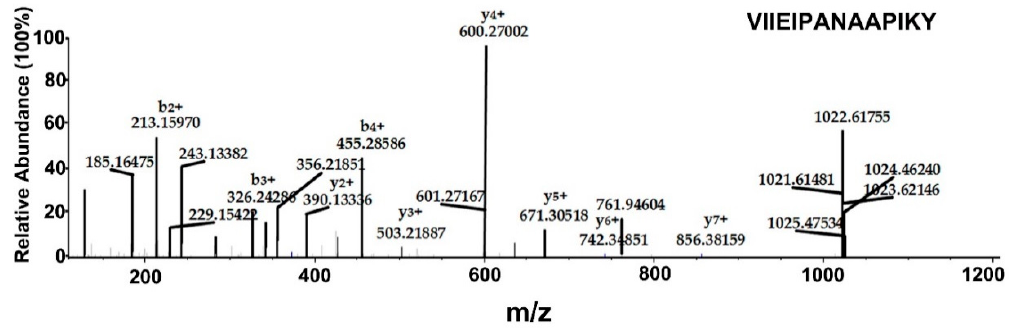
10 of 18 Figure 8. Gel filtration analysis of the global fold of AbPPase. ( A ) Gel filtration profile of AbPPase in the presence of 1.6 mM PPi and 1.6 mM MgCl 2 . The elution peak of AbPPase falls at 13.36 mL. ( B ) The gel filtration profile of AbPPase in the presence of 200 mM NaCl,1.6 mM PPi and 1.6 mM MgCl 2 . The elution peak of AbPPase falls at 13.32 mL. 2.4. AbPPase Lys30 is Phosphorylated during PPi Hydrolysis Here, we used MS to identified chemical modifications of AbPPase during PPi hydrolysis. After 10 min of the enzyme reaction, chymotrypsin was added to the reaction to digest AbPPase, and unreacted AbPPase was used as a negative control. MS identified 45 peptides, covering 98.2% of the enzyme. Our results showed that several methionine and cysteine residues could be oxidized and carbamidomethylated, respectively (Table 2). During hydrolysis, Lys30 was found to be phosphorylated (Table 2, Figure 9). In contrast, Lys30 remained unphosphorylated in the negative control experiment. This indicates that phosphorylation of Lys30 is specific to the hydrolysis reaction. However, only two phosphorylated fragments containing Lys30 were detected, suggesting that the